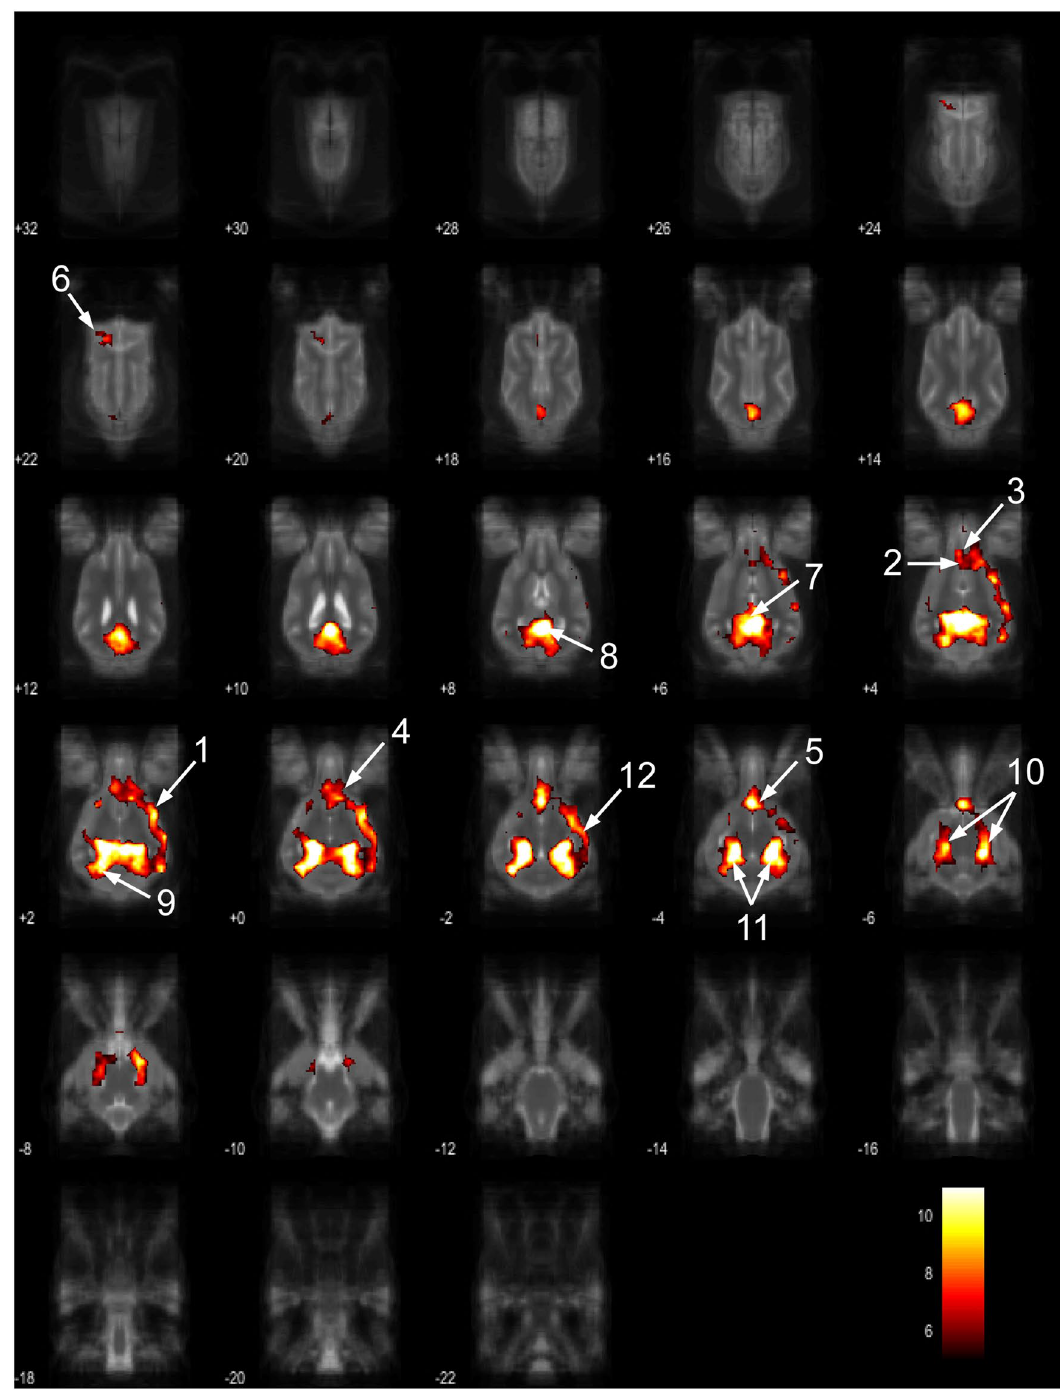
Figure 4. Resting-state network component A from the 15 component gICA. We report the results with a voxel-wise FDR corrected p < 0.001 and cluster treshold of FDR corrected p < 0.005. gICA components are presented as thresholded T-maps, corrected for multiple comparisons, overlaid on the Nitzsche atlas 15 . 1. rostral composit gyrus, 2. cingulate gyrus, 3. straight gyrus, 4. Subcallosal area, 5. diagonal gyrus, 6. Left premotor area, 7. Medial cingulate gyrus, 8. Bilateral caudal regions of the cingulate gyrus, 9. splenial gyrus, 10. bilateral hippocampus, 11. bilateral parahippocampal gyrus, 12. caudal composit